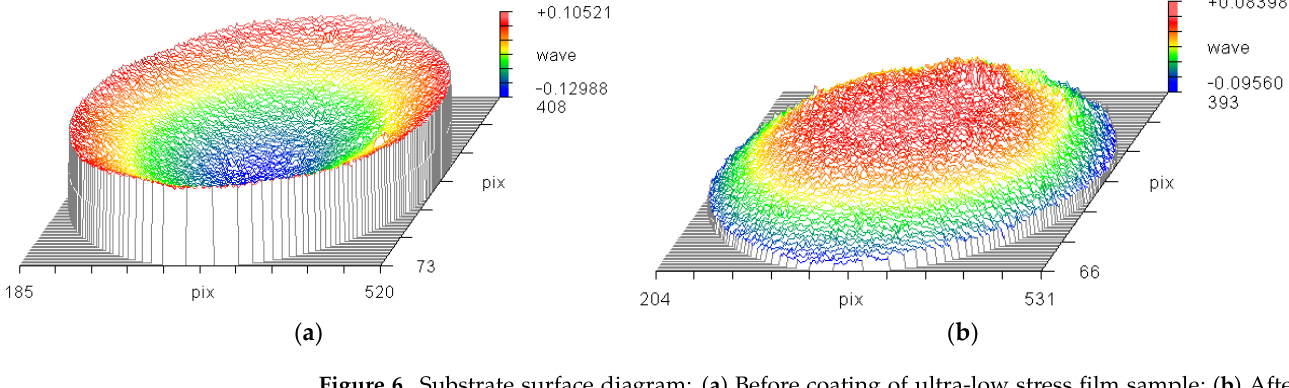
Figure 6. Substrate surface diagram: ( a ) Before coating of ultra-low stress film sample; ( b ) After coating of ultra-low stress film sample.